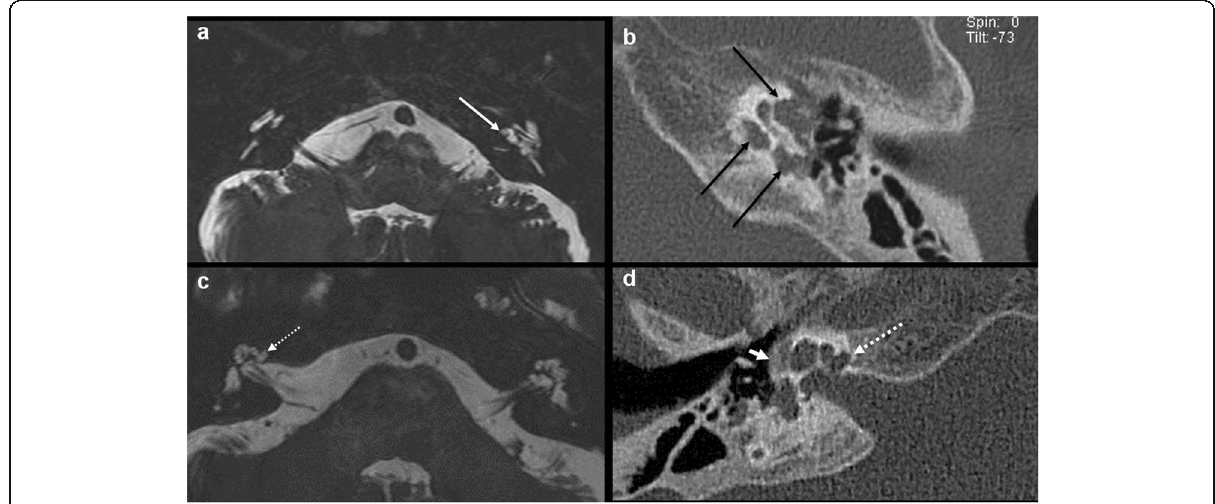
Fig. 6 A 64-year-old male patient with heavy bilateral SNHL (case 7). Axial CISS image ( a ) shows curvilinear T2 hyperintensities (arrow) surrounding the left cochlea. Subsequent axial HRCT image ( b ) confirms extensive very hypodense plaques (arrows) in the left pericochlear region, likely long-standing disease. Axial CISS image ( c ) at a lower level also shows a small right IAC diverticulum (dashed arrow), confirmed on subsequent axial HRCT image ( d ) as an ‘ ear-like ’ outpouching anterior to the right IAC (dashed arrow). Also note the large plaque in the right FA region (short